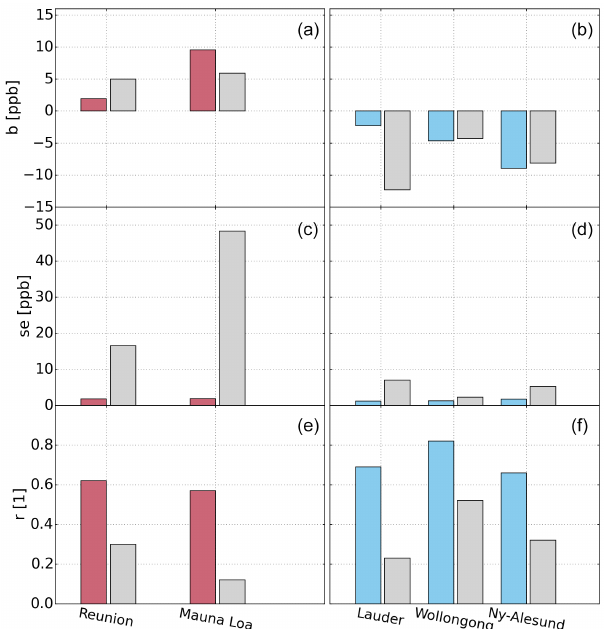
Figure 10. Mean bias SCIAMACHY – FTS (a, b) , standard error of the mean bias (c, d) and Pearson correlation coefficient of SCIA- MACHY with FTS (e, f) derived from monthly medians as shown in Figs. 8 and 9. Measurements of NDACC (a, c, e) and TCCON stations (b, d, f) are compared with clear-sky (grey) and cloudy (coloured) SCIAMACHY